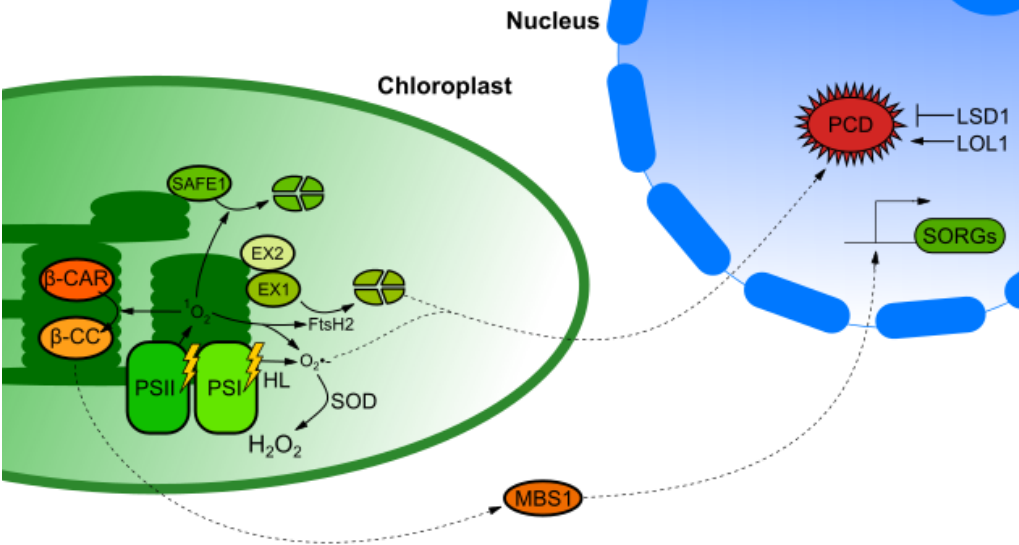
Figure 2. Retrograde-signaling pathways mediated by singlet oxygen in mature mesophyll cell. High light stress induces ROS production in photosystem I (PSI) and PSII. Depending on its concentration singlet oxygen induce different pathways. At low concentrations it promotes degradation of EXECUTER1 (EX1) by FtsH2 protease and induce EX1-mediated PCD. It is negatively regulated by LESION STIMULATING DISEASE1 (LSD1) and positively by its homolog LOL1. SAFEGUARD1 (SAFE1) similarly, to EX1 protects grana margins from oxidative damage by singlet oxygen. At high concentration singlet oxygen oxidizes β -carotene to β -cyclocitral and induces expression of many singlet oxygen related genes (SORGs) through METHYLENE BLUE SENSITIVITY 1 (MBS1). Dotted lines represent pathways which lack experimental evidence or exact nature of indicated regulation is still unknown.